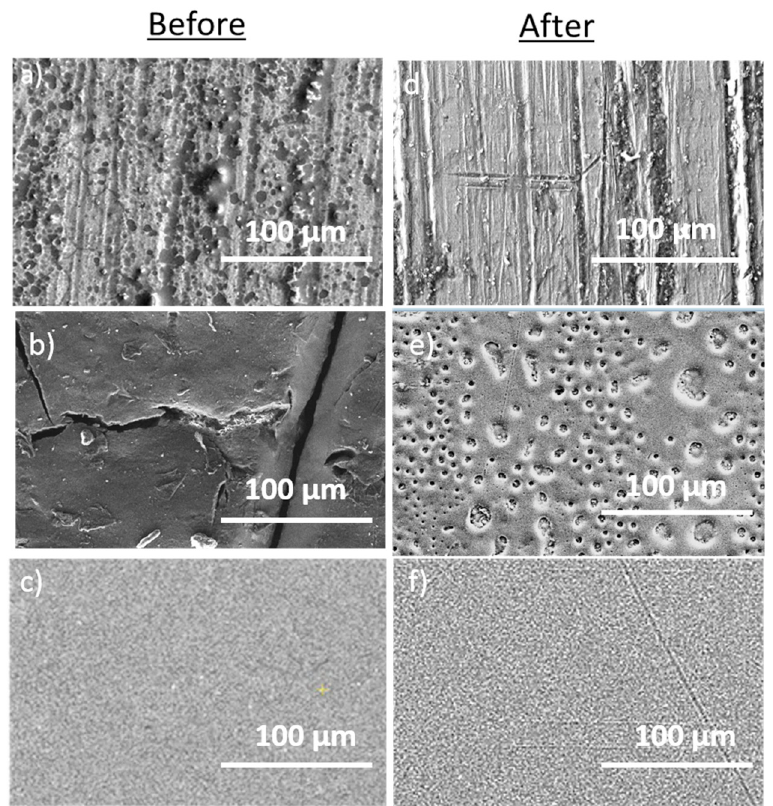
Figure 10. Top view SEM images for the at 500 × magnification before the cycles: ( a ) sol-gel coating, ( b ) silicone sprayed coating, and ( c ) electrostatic sprayed coating; and after the icing cycles: ( d ) sol-gel coating, ( e ) silicone sprayed coating, and ( f ) electrostatic sprayed coating.